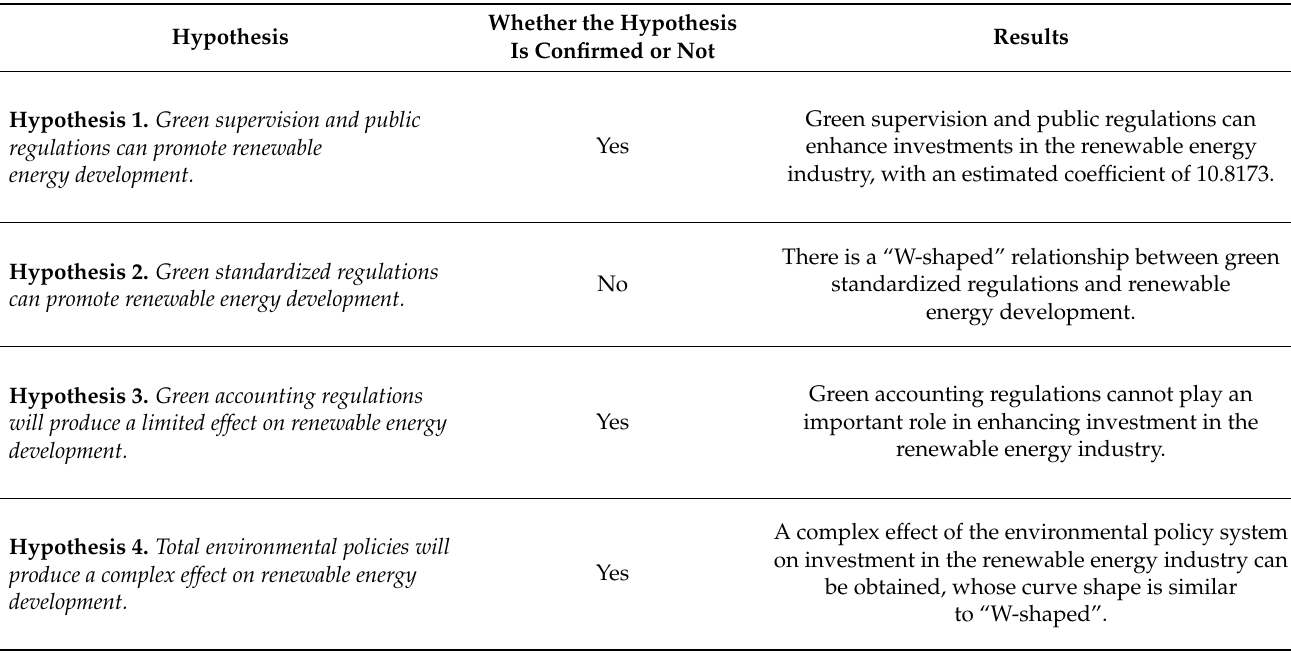
Table 7. A summary of empirical